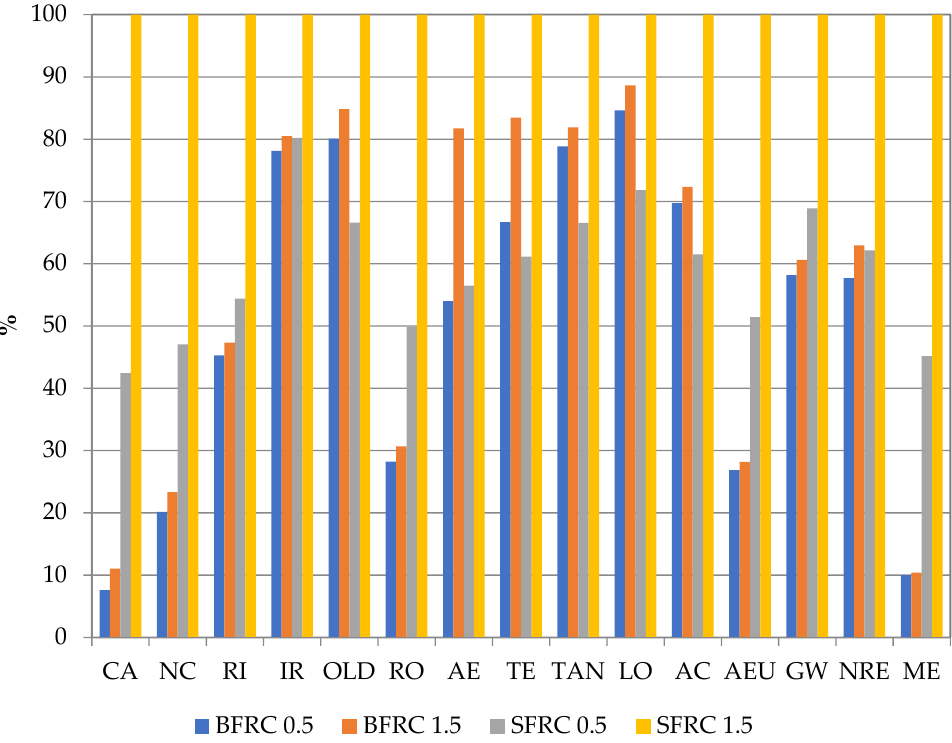
Figure 4. Midpoint comparison of concrete reinforced by basalt and steel fibers.